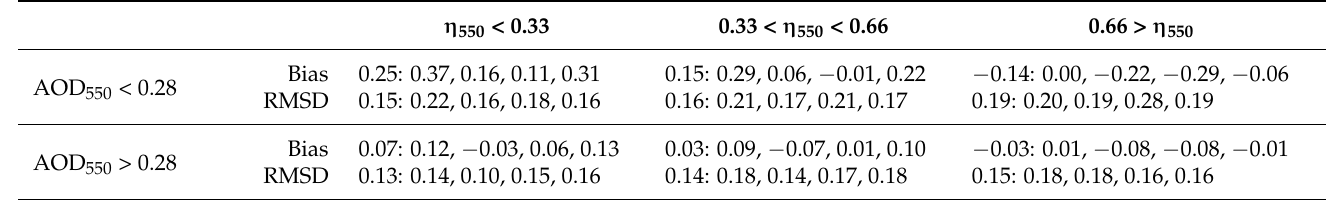
Table 4. Diagnostic mean bias and root mean square deviation (RMSD) for fine mode fraction ( η 550 ) group for the C4C consensus followed by the 4 members. η 550 <